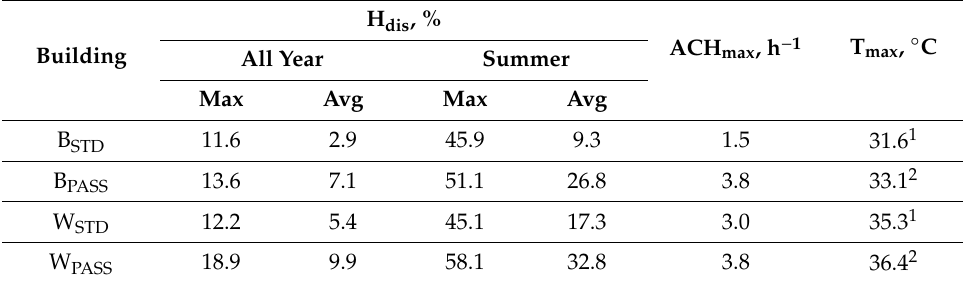
Table 6. Percentage of discomfort hours (H dis ) in relation to the occupied hours in the rooms (maximum obtained value and average value for all the rooms), the maximum air change rate (ACH max ) obtained by opening windows and the maximum calculated temperature (T max ) in the